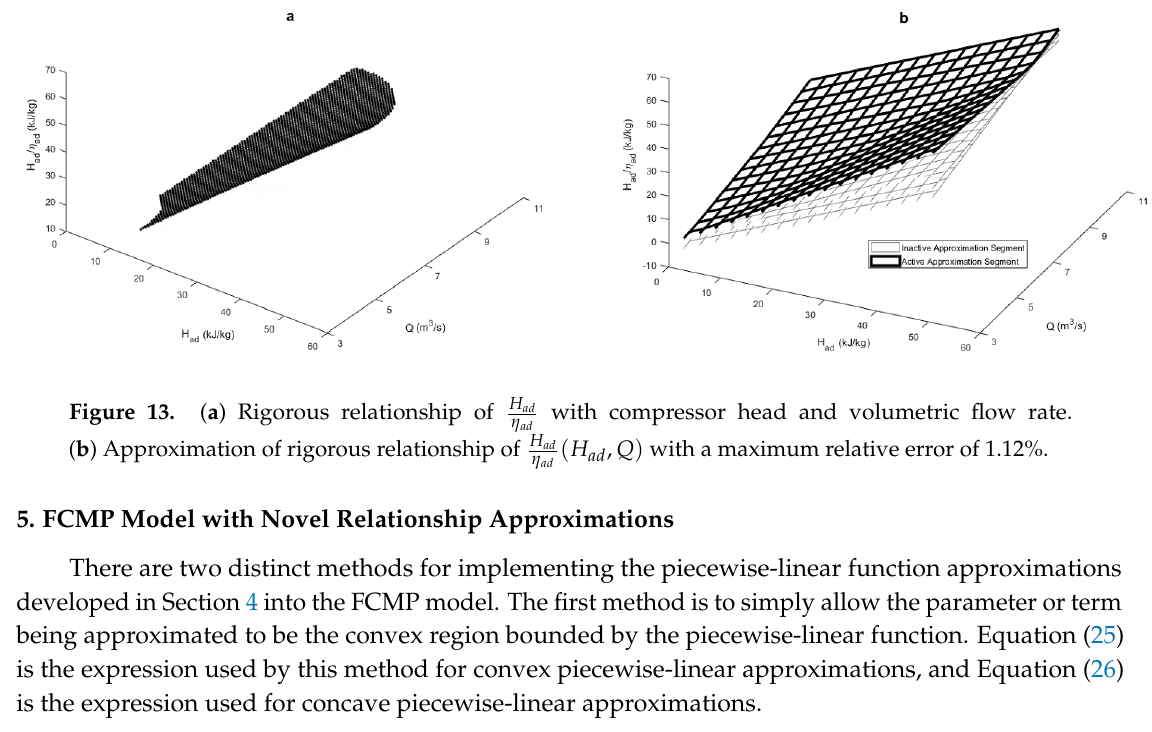
with compressor head and volumetric flow rate. η ad ( H ) with a maximum relative error of ad , Q η ad